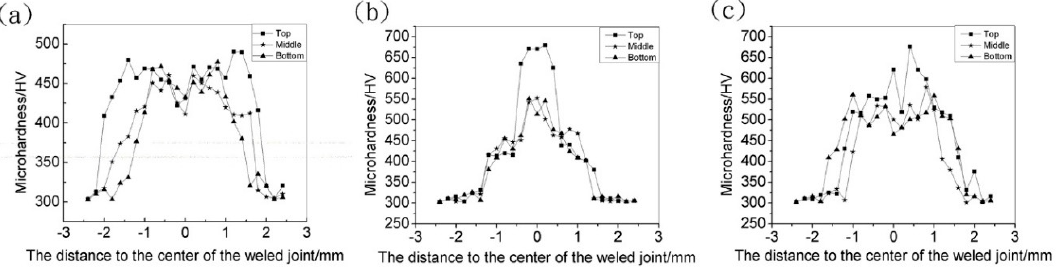
Figure 7. Hardness distribution of the weld along weld-width direction ( a – c ): ( a ) sample I; ( b ) sample II; ( c ) sample